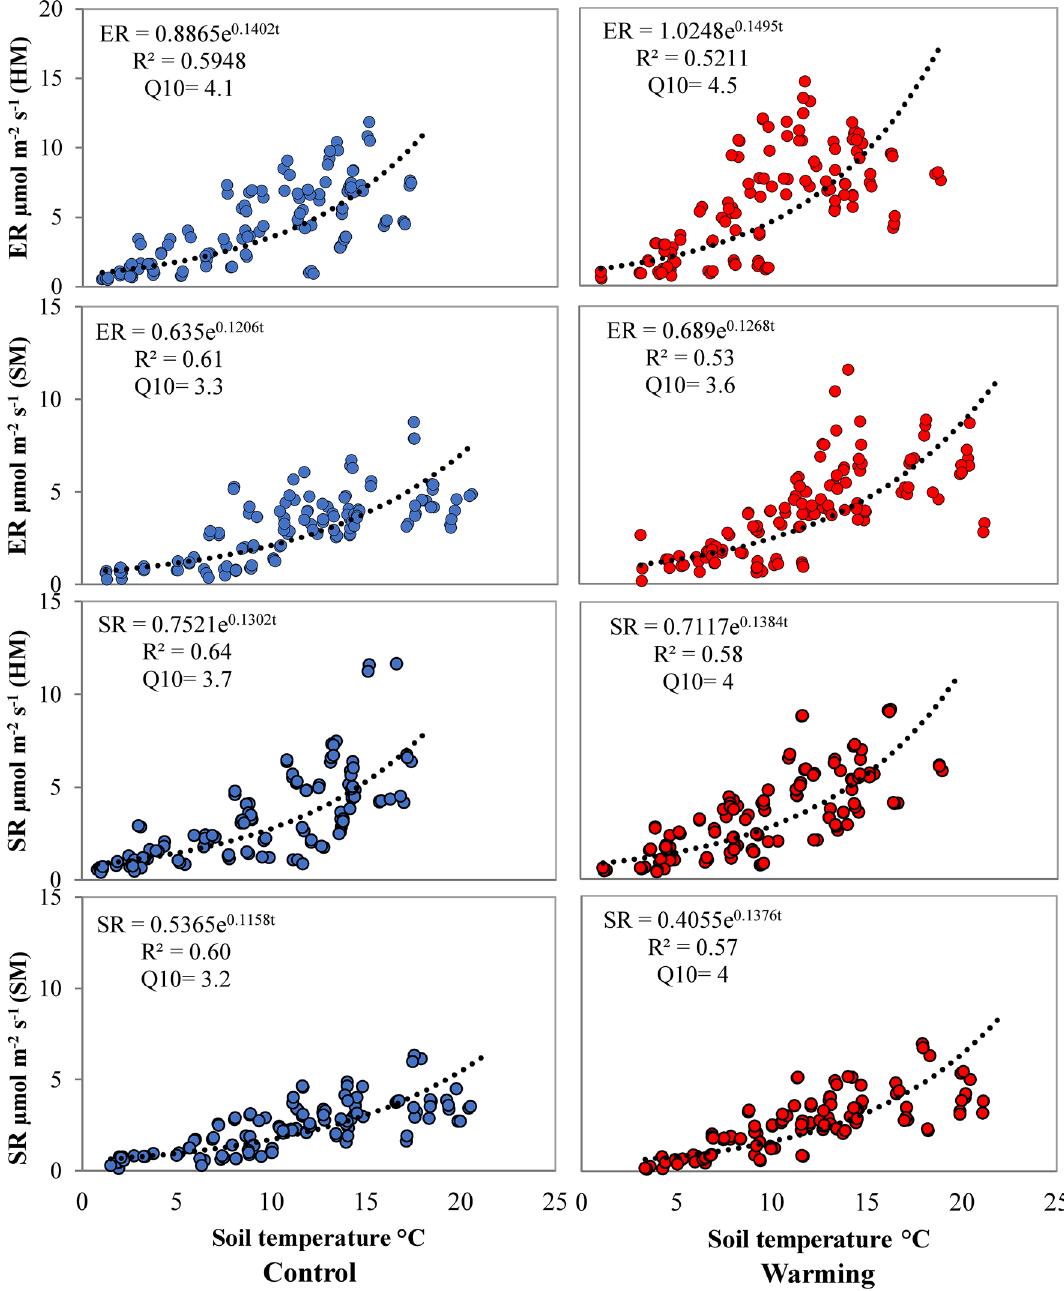
Figure 3. Exponential relationships between ecosystem respiration (ER) and soil temperature and soil respiration (SR) and soil temperature across growing season in control and warming plots in Herbaceous Meadow (HM) and Sedge Meadow